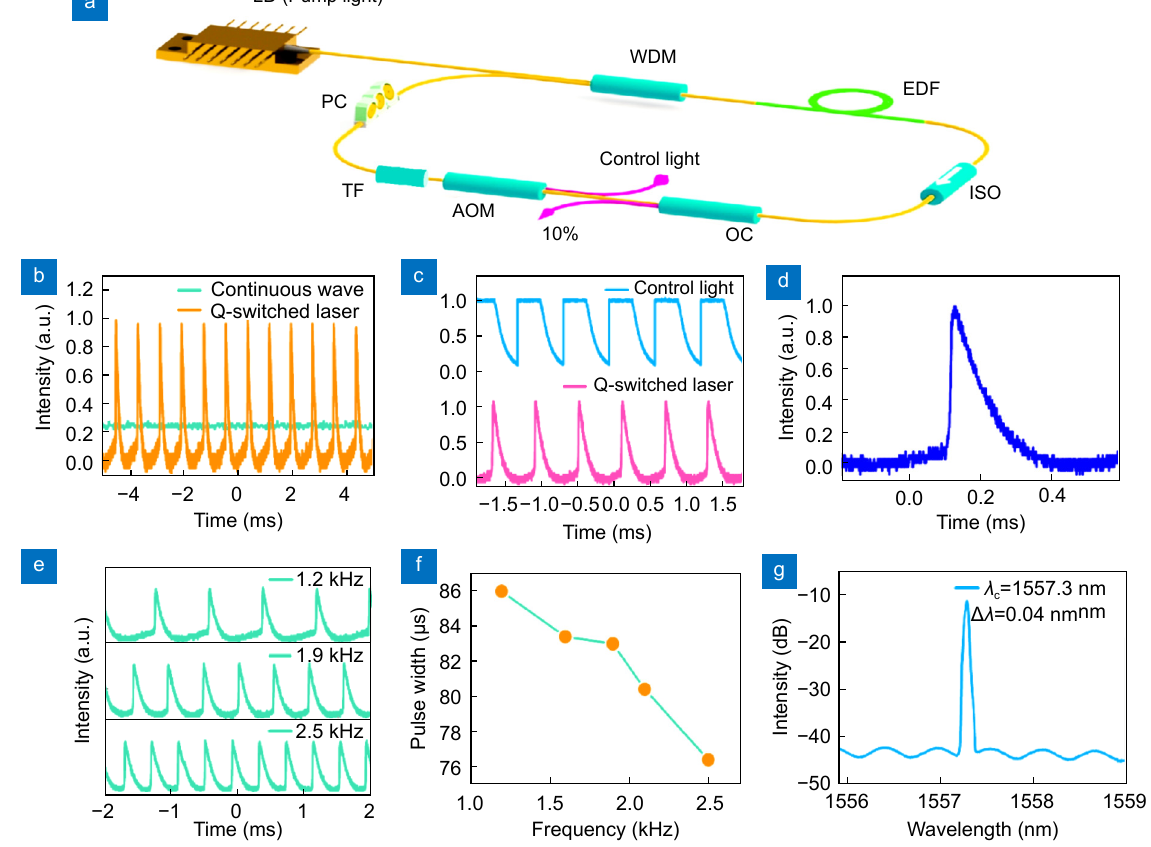
Fig. 5 | ( a ) The experimental diagram of the all-optical actively Q-switched lasers. ( b ) The state of continuous wave and Q-switched pulse laser. ( c ) The waveform of control light and pulse train. ( d ) Single pulse profile in (c). ( e ) The pulse trains under different modulation frequency. ( f ) The pulse width of Q-switched laser versus the modulation frequency. ( g ) The output spectrum of Q-switched